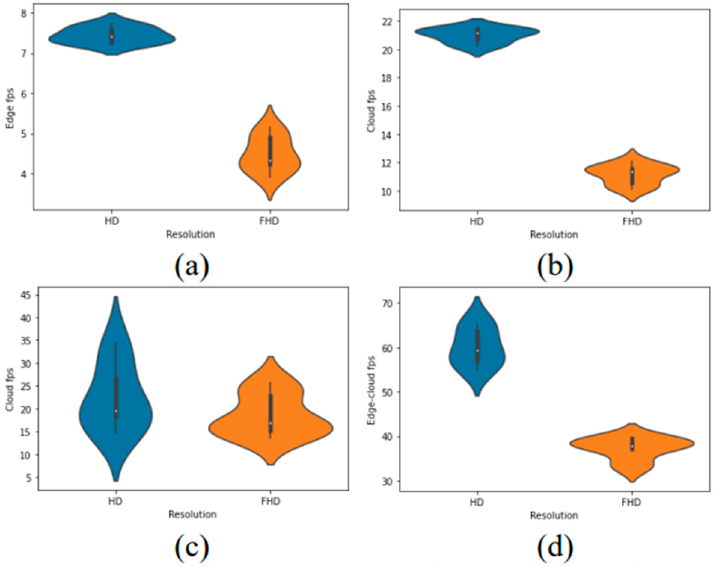
Figure 4. Violin plot of the processing speed achieved on the ( a ) edge, ( b ) cloud 1, ( c ) cloud 2, and ( d ) edge–cloud for each input video resolution. ( d ) edge–cloud for each input video